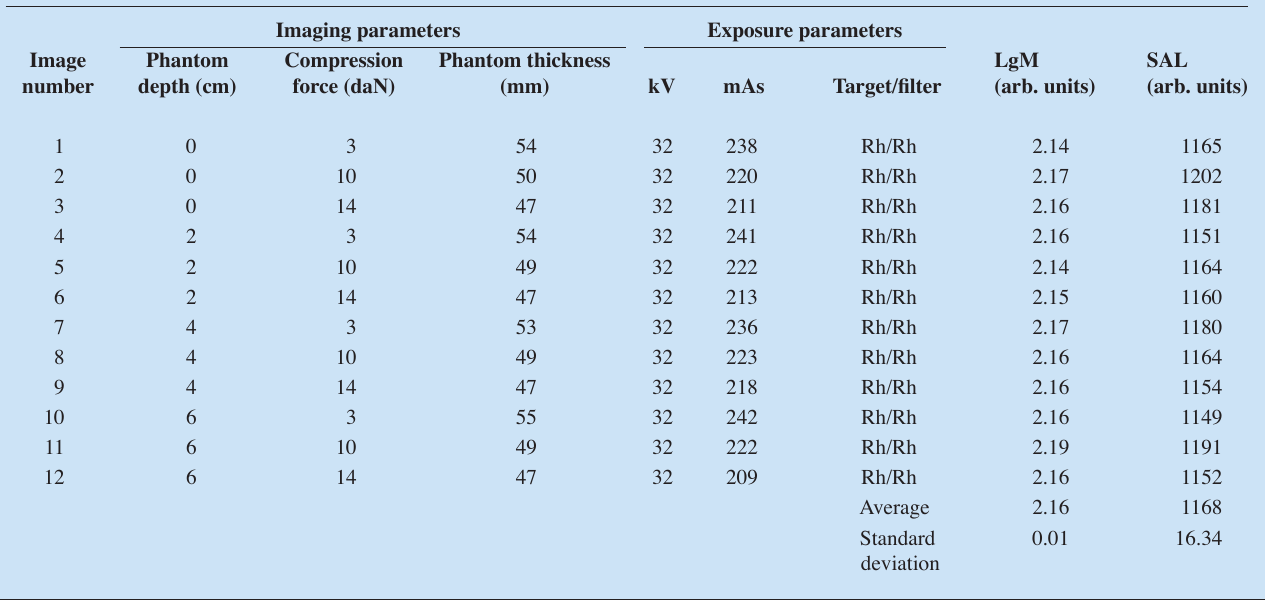
Table III. Contrast-detail phantom imaging